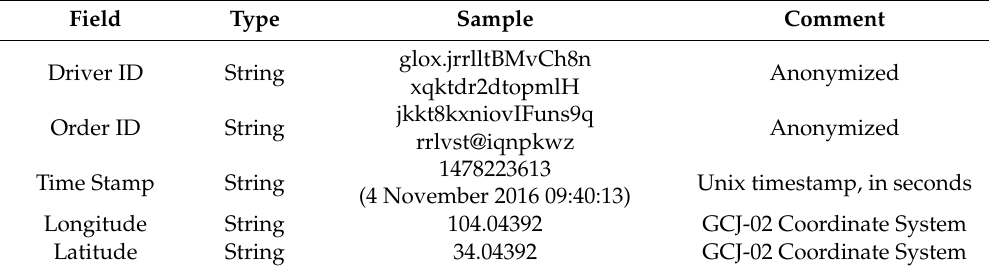
Table 2. An instance of online taxi-hailing GPS data.